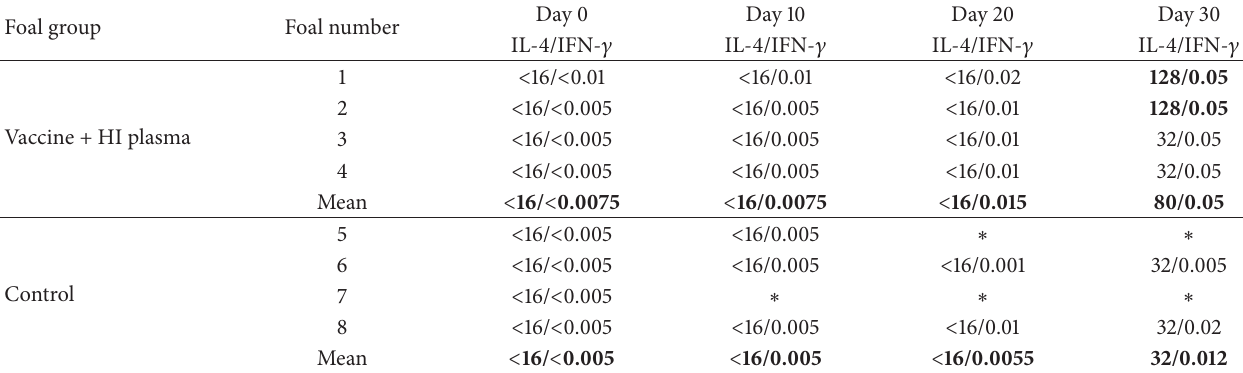
Table 3: IL-4 (pg/mL) and IFN- 𝛾 (ng/mL) concentration in challenged foals. Foal